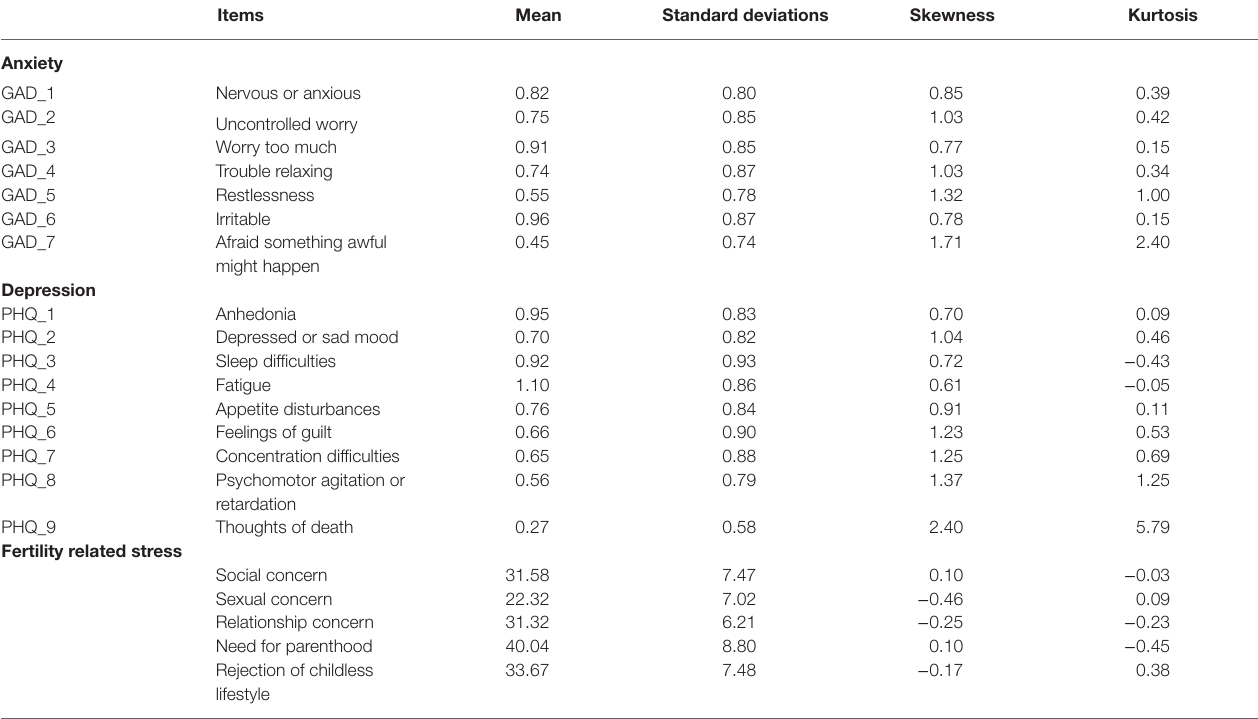
TABLE 1 | Symptoms, sample means, standard deviations, and distribution.